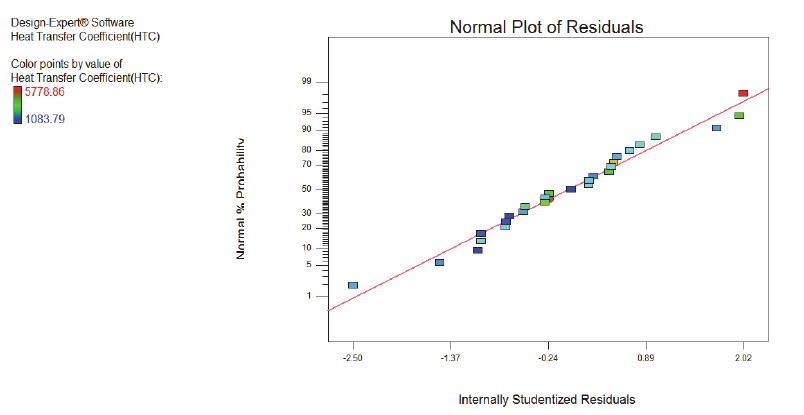
Fig. 8. Normal plot of the